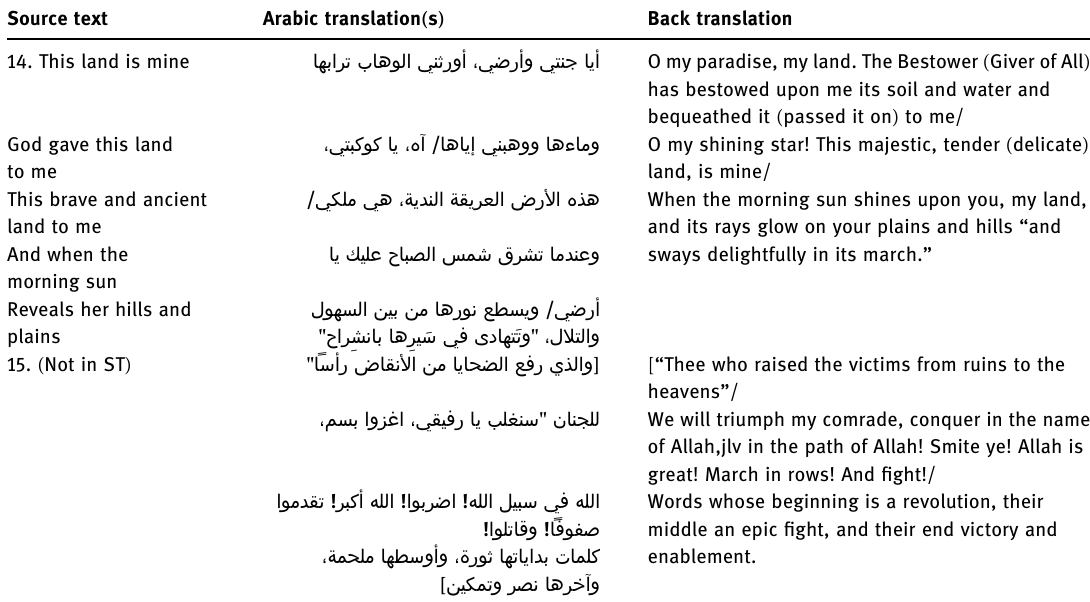
Table 5: Examples of visual impact on the decision - making process Source